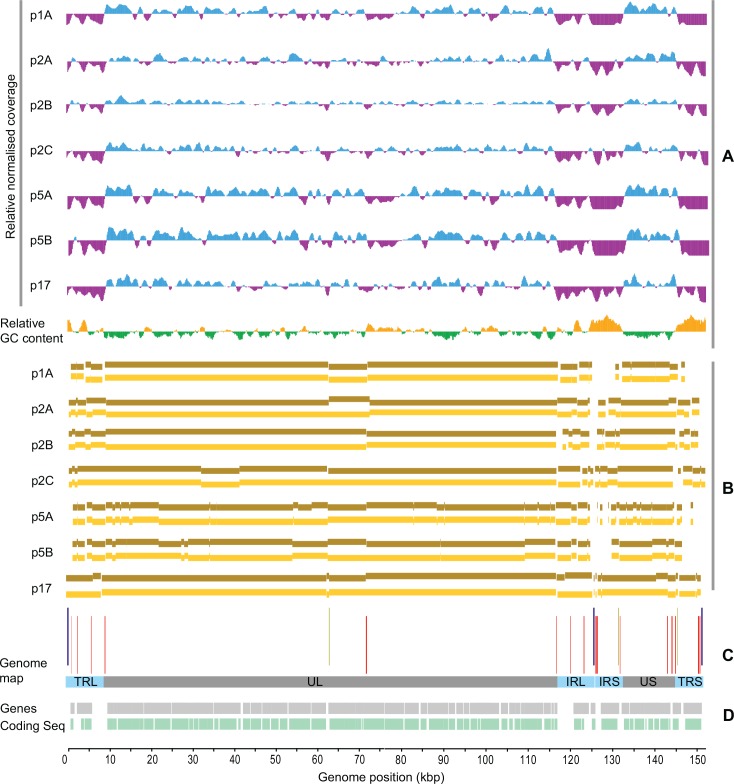
454 read coverage, GC content and comparative mapping of contigs across the genome map.(A): Relative normalized read coverage per sample (454 data) -blue and purple bars represent values beyond and below the average read coverage of the mapping assembly- in correlation with the relative GC content across the reference genome (NC_001806.2) -orange and green bars represent values beyond and below the average GC content- (B): Comparative mapping of solo 454 (brown) and hybrid 454/MinION (yellow) generated contigs. (C): Repetitive elements plotting across the reference genome (NC_001806.2)–“a” sequence in blue, VNTRs in red, stem loops in yellow bars-. (D): Basic structure of the HSV1 genome; UL and US (dark grey) stand for Unique Long and Unique Short region respectively, while TR(L/S) and IR(L/S) (light blue) stand for Terminal and Internal -inverted- Repeats flanging the UL and the US region respectively. Genes (light grey) and coding sequences (light green).